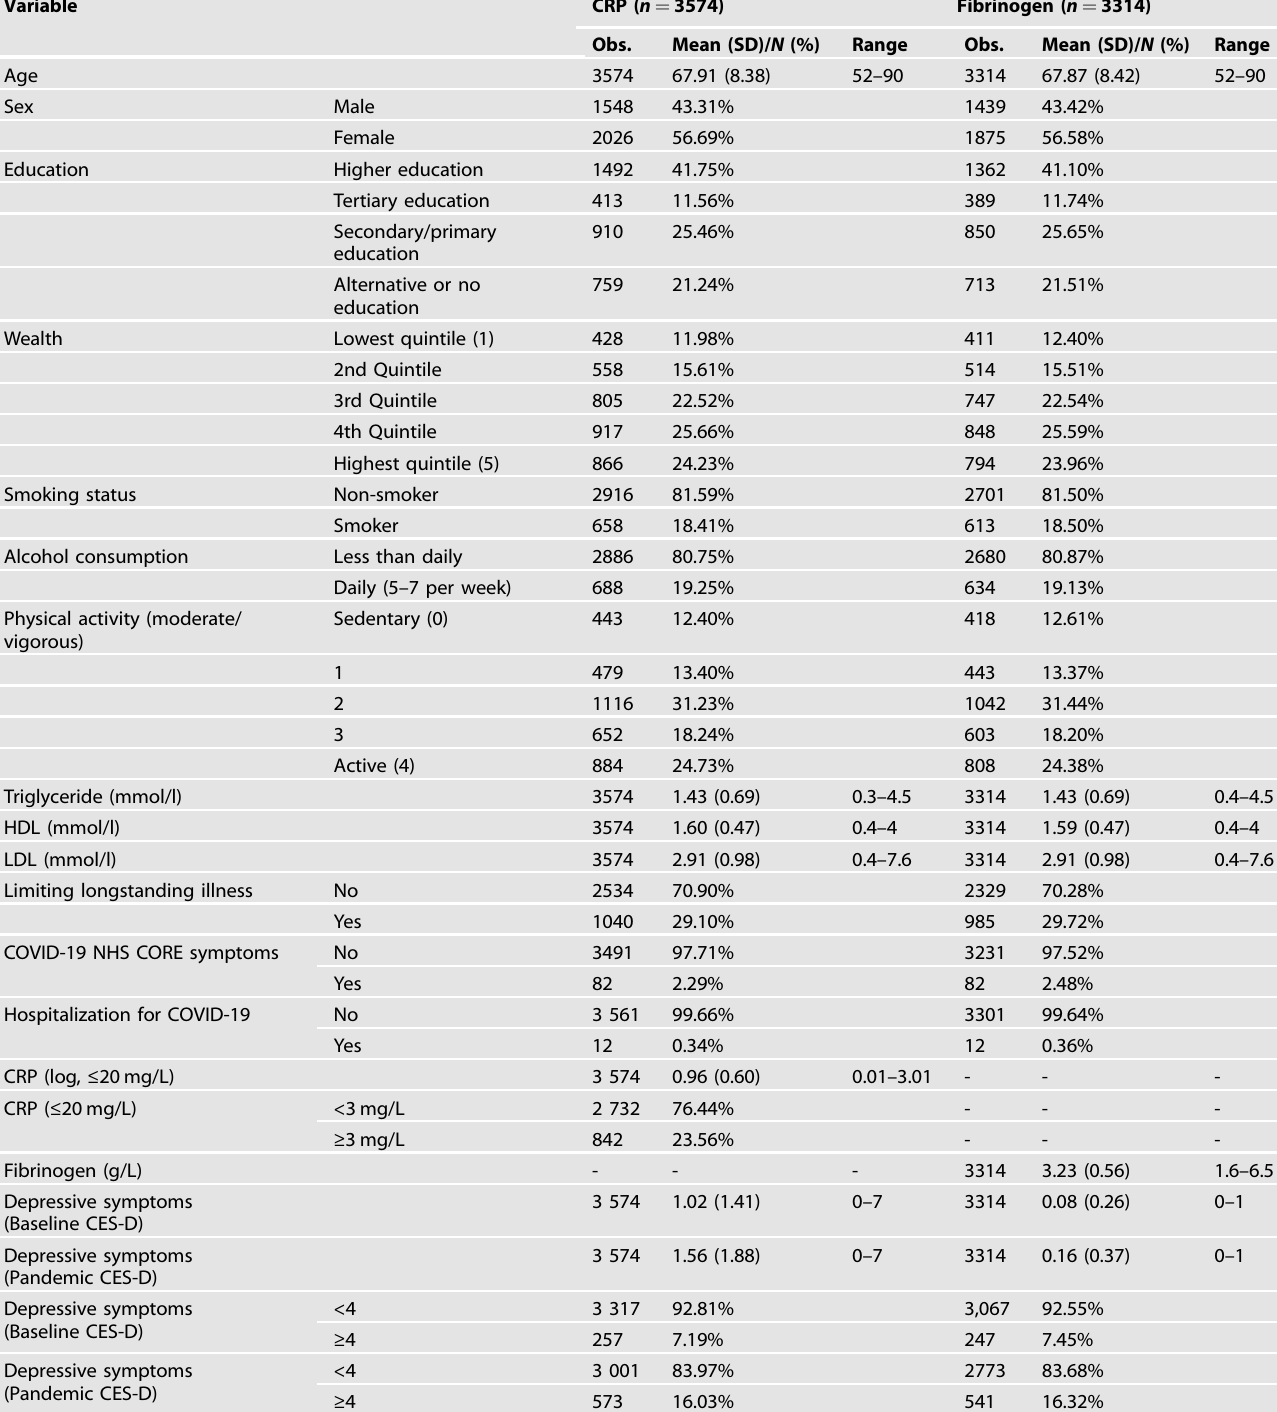
Table 1. Sample characteristics for the CRP and fi brinogen